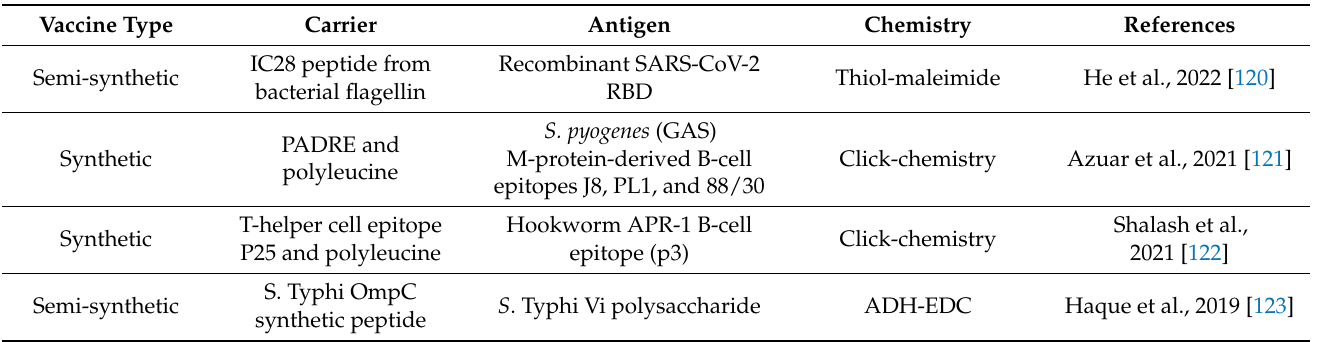
Table 6. Peptide conjugation